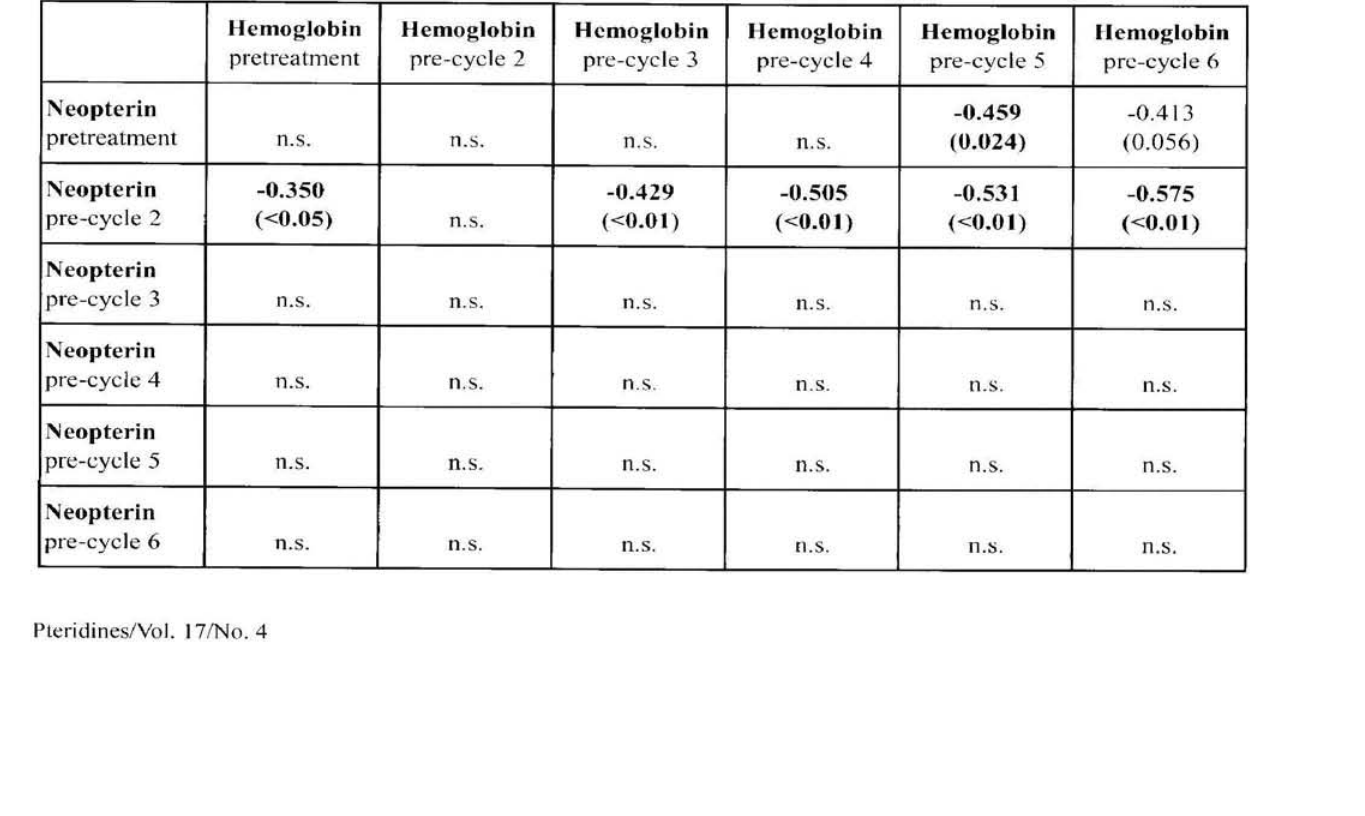
Table 3: Correlations between urinary neopterin and peripheral blood hemoglobin concentrations (r s and p-val- ues in brackets are shown, significant correlations are highlighted in bold type)